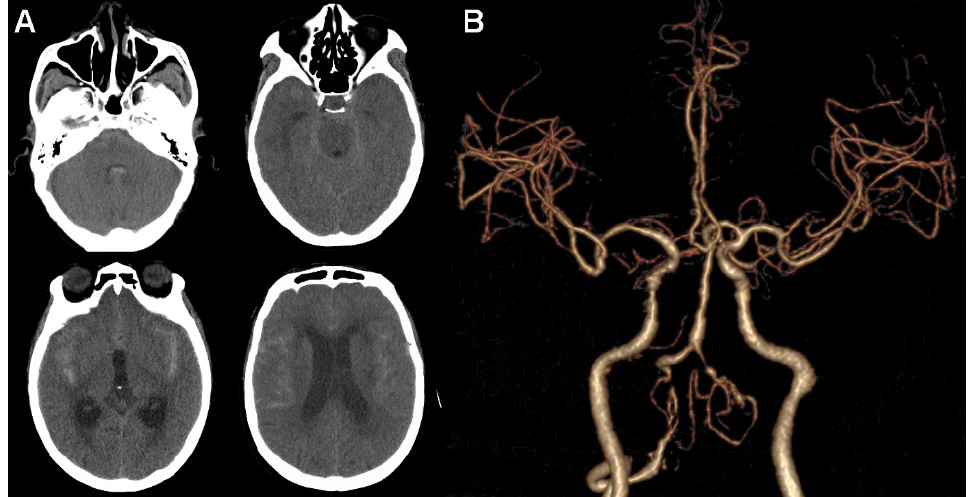
Figure 1. Head computed tomographic angiography scan. ( A ) Extensive subarachnoid hemorrhage is shown in axial images. ( B ) No obvious aneurysm or other vascular malformations in intracranial arteries are observed.